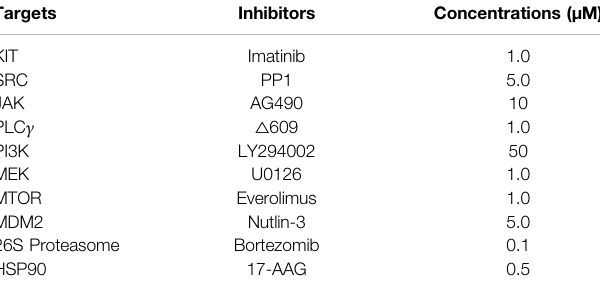
TABLE1 | Screening of small molecular inhibitors in KIT-independent GIST62.